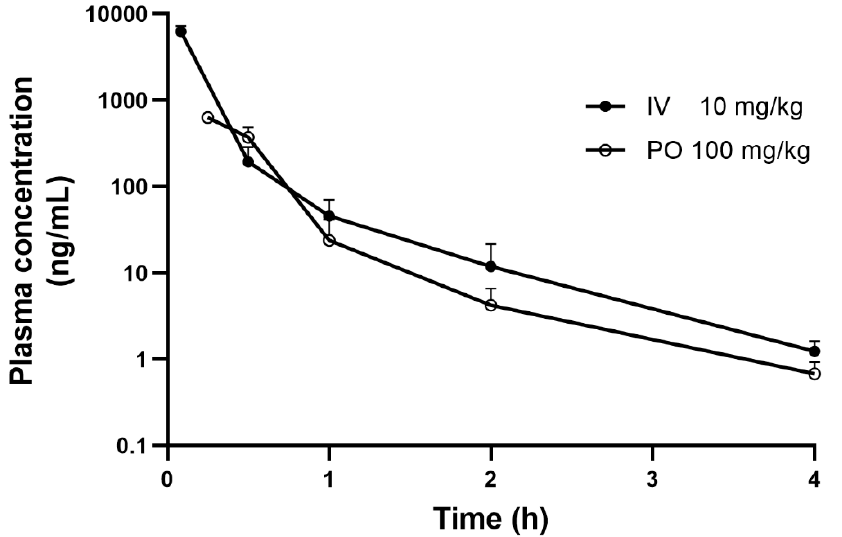
Figure 2. Mean plasma concentration–time curves of 13 C 4 SA in mice after a single IV and PO dose (mean ± SD, n = 3). Table 5. 13 C 4 SA pharmacokinetic parameters in plasma (mean ± SD, n = 3).